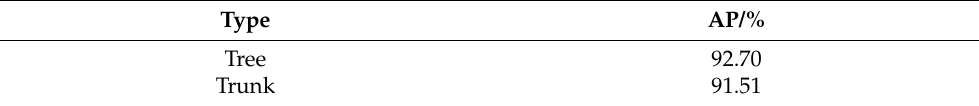
Table 1. Detection